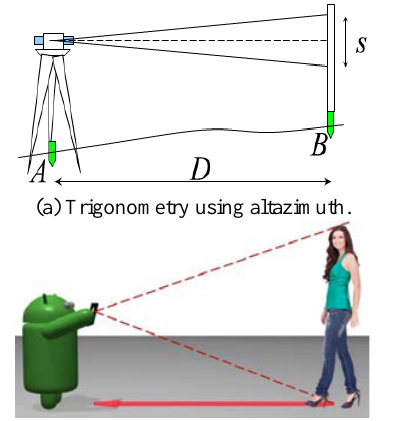
Figure 1. Illustrations of trigonometry.